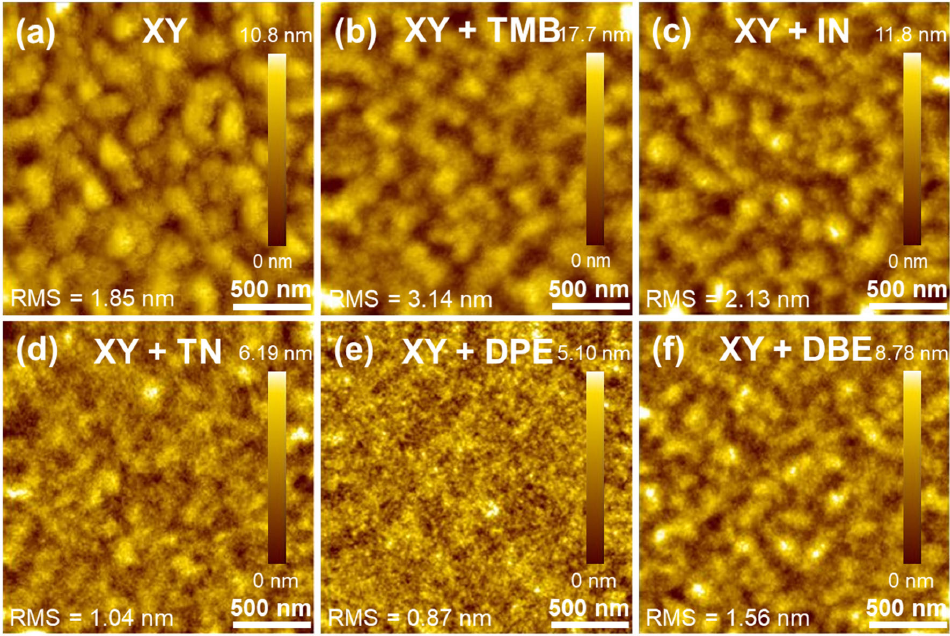
Figure 6. AFM topography images of ( a ) XY ‐ , ( b ) XY + TMB ‐ , ( c ) XY + IN ‐ , ( d ) XY + TN ‐ , ( e ) XY + DPE ‐ , and ( f ) XY + DBE ‐ based blend films.